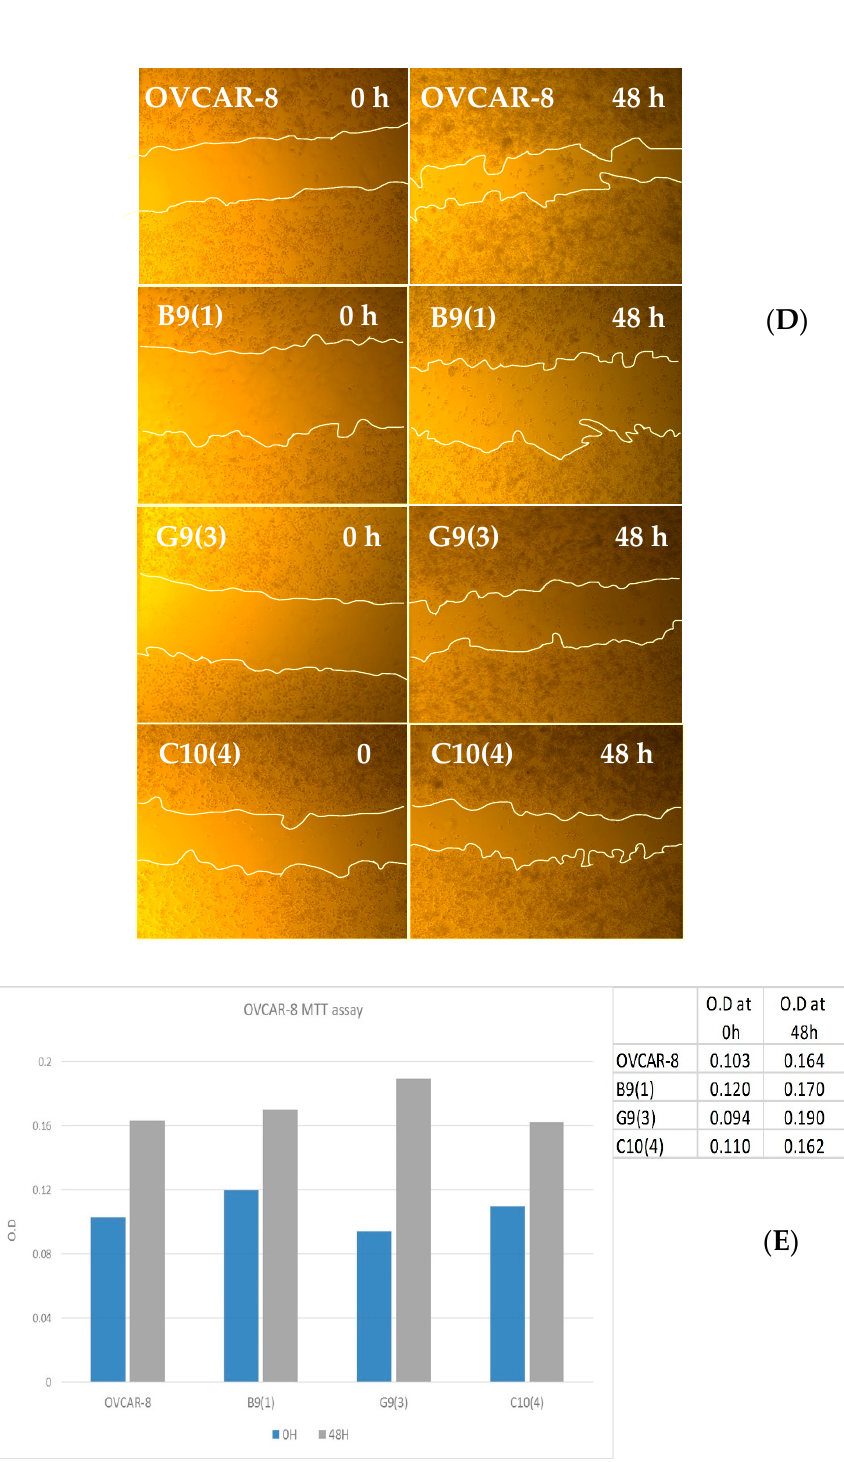
Figure 2 . ( A ) Graph and table showing the percentage and number of OVCAR-8 KO cells that migrated through the matrigel compared to the control cells, with a p -value for each line (* = significant difference). ( B ) Graph and table showing the percentage and number of OVCAR-8 KO cells that migrated throughout collagen IV compared to control cells, with a p -value for each line (* = significant difference). ( C – D ) Wound healing assay. Graph, table, and images showing the percentage of the scratch closed by KO cells and OVCAR-8 control cells, with a p -value for each line (* = significant difference). ( E ) MTT assay. A graph showing the optical density O.D. of OVCAR-8 KO and control cells at 0 and 48 h ( p > 0.05).